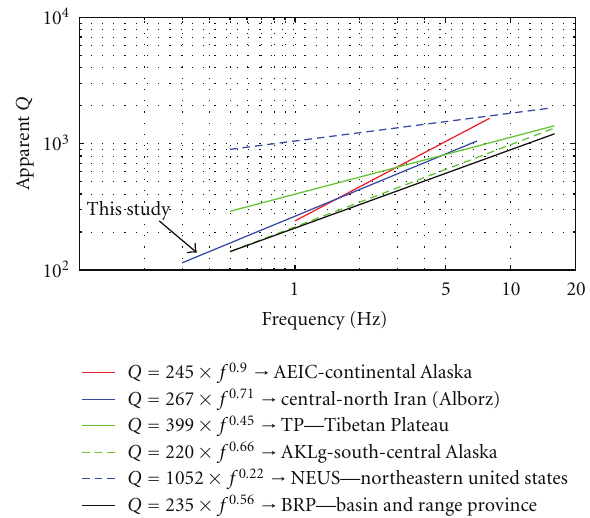
Figure 5: Comparison between the proposed formulas for other tectonic regions in the world. It can be seen that the proposed formulas has an acceptable conformity with other functions of quality